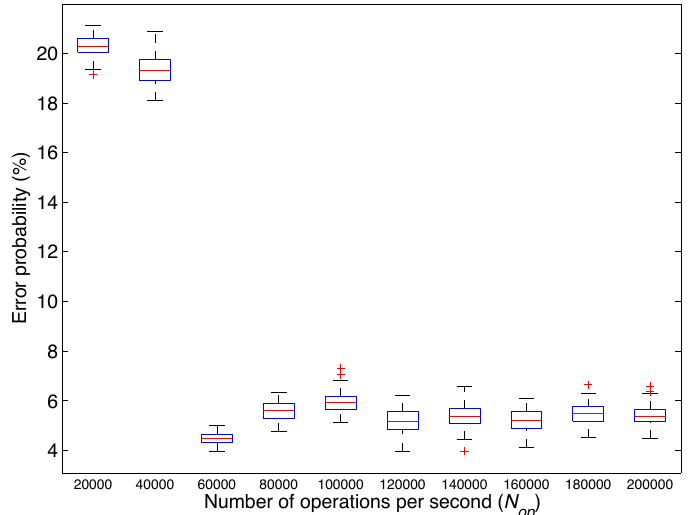
Figure 11. Box plot of the probability of error obtained by the classifiers for different values of the maximum number of operations per second ( N emotional